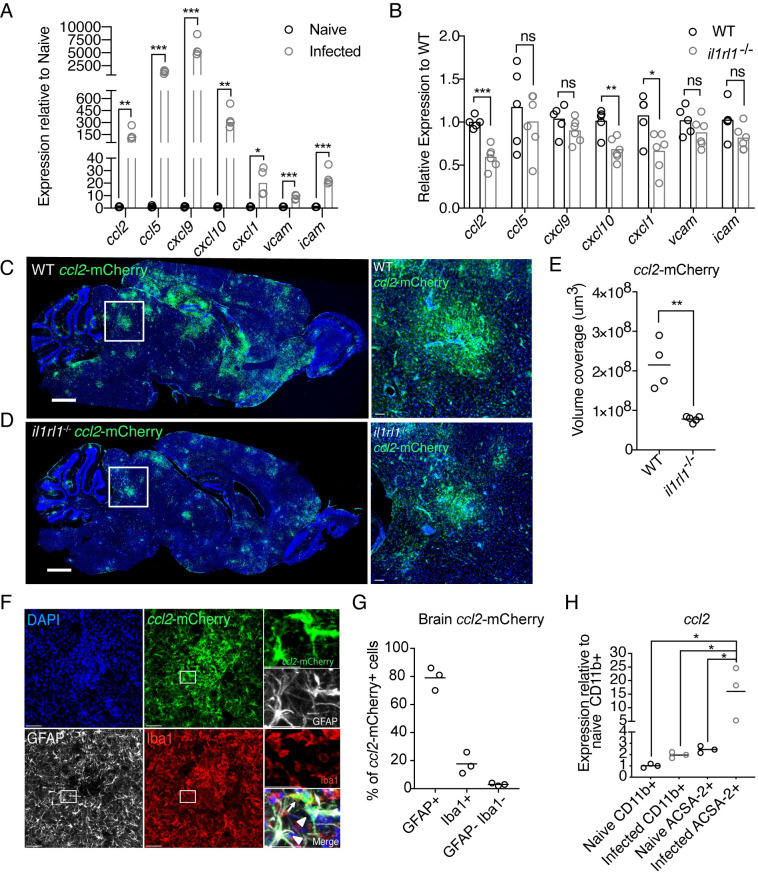
IL-33 signaling induces factors which recruit immune cells to the brain.(A and B) Real time PCR from whole brain homogenate was used to assess changes in chemokine and adhesion factor gene expression from naïve to infected animals (A) and between wildtype and il1rl1-deficient animals (B) at four weeks post infection. (C-E) Visualization (C,D) and quantification (E) of ccl2-RFP reporter expression by mCherry staining (green) in infected brain tissue by confocal fluorescence microscopy. (F and G) Breakdown of ccl2-mCherry reporter positivity by cell type using confocal microscopy. mCherry (green) is colocalized with Iba1+ macrophages (red) or activated, GFAP+ astrocytes (white). (H) Cell-type specific magnetic enrichment for myeloid cells (CD11b+) or astrocytes (CD11b- and ACSA-2+) in naïve and chronically infected brain tissue. Single cell suspensions of enriched cells were resuspended in Trizol, RNA extracted, and run by real time PCR for ccl2 expression. Statistical significance was determined by two-tailed t-test (A, B, E) or One-way ANOVA with Tukey’s test (H). * = p < .05, ** = p < .01, *** = p < .001. Scale bars indicate 2000μm (C,D) and 50μm (F).